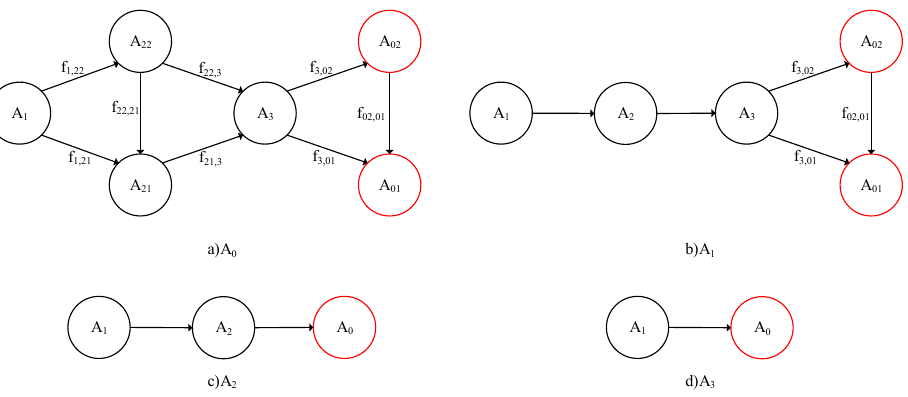
Figure 4. Sub-modes of General Mode A for the decay chain of the fission gas nuclide.